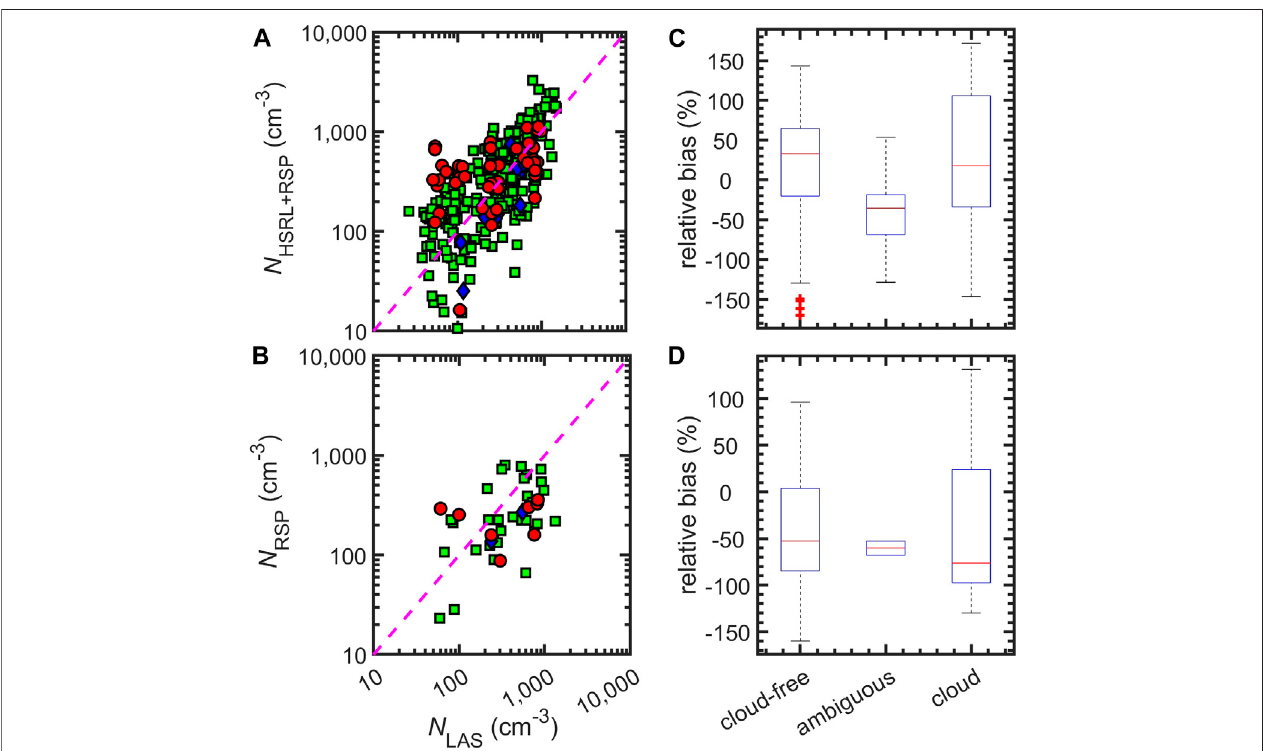
FIGURE 6 | Log-log plots of (A) vertically resolved N HSRL+RSP vs. in situ N LAS and (B) column-averaged N RSP vs. in situ N LAS . The collocated vertical pro fi le data comefrom ACTIVATE 2020. The green squares correspond todata from vertical pro fi les where all in situ dataare classi fi ed as cloud-free, blue diamonds correspondto the vertical pro fi les that have one or more in situ data point that is classi fi ed as ambiguous but no points classi fi ed as cloud, and the red circles correspond to data from vertical pro fi les where at least one data point was classi fi ed as cloud. The dashed-magenta line indicates the one-to-one line. Panels (C) and (D) are box plots illustratingthespreadinrelativebiasofpanel (A) andpanel (B) ,respectively.Datafortheseboxplotscorrespondtothesamecategoriesaspanels (A) and (B) (i.e.,cloud- free,ambiguous,andcloud).Additionalgoodnessof fi tstatisticsforpanels (A) and (B) areshowninTbl.3.Redmarkersonpanels (C) or (D) arepointsthatwere fl agged as statistical outliers. An outlier is a value that is more than 1.5 times the interquartile range away from the bottom or top of box.